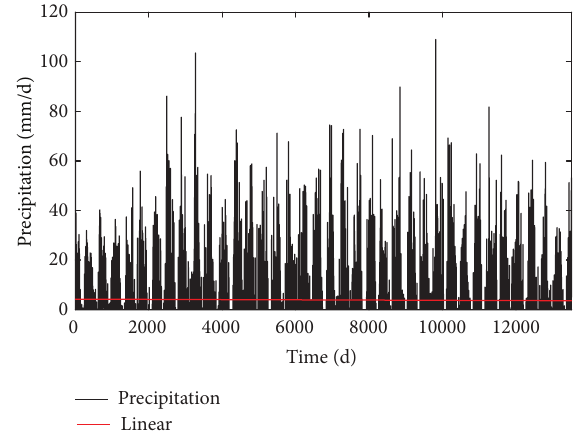
Figure 2: Areal daily precipitation from 1978 to 2006.